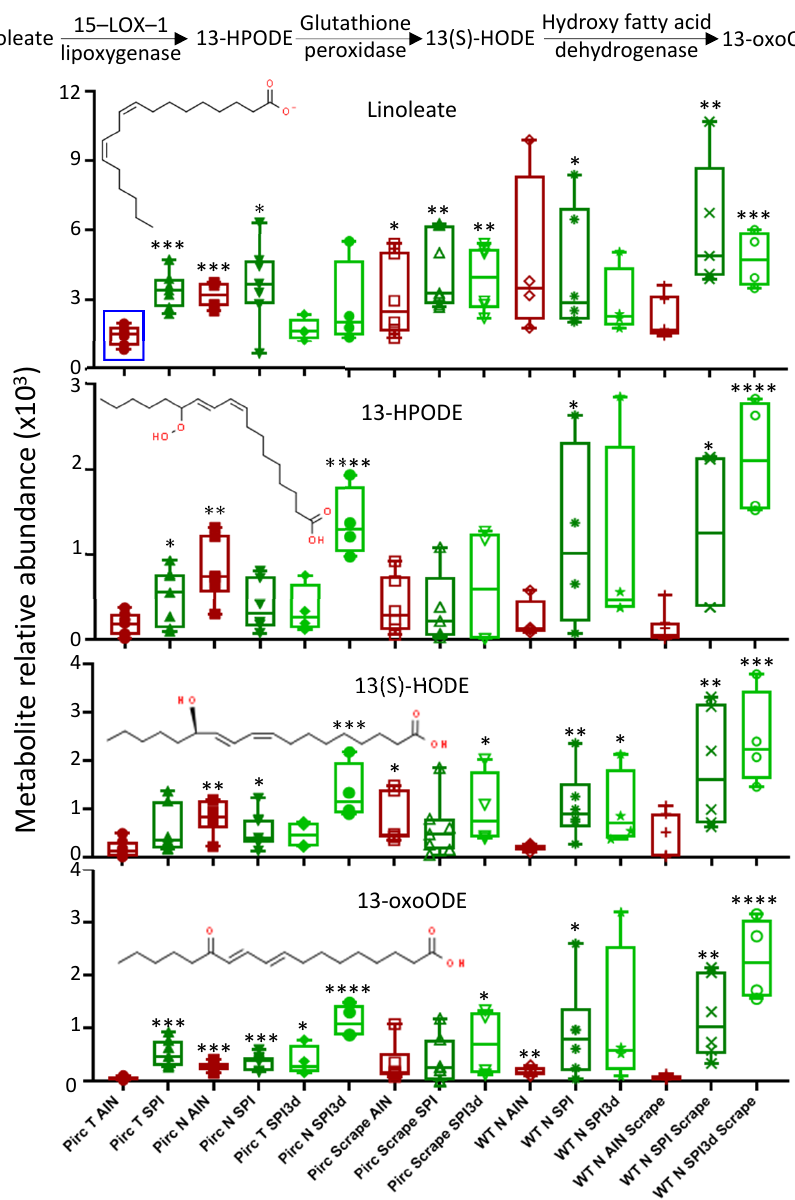
Figure 4. Linoleate and metabolites in rat colon tissues. Datapoints represent individual rats as biological replicates (n = 4–7). One–way ANOVA with Tukey correction; * p < 0.05; ** p <